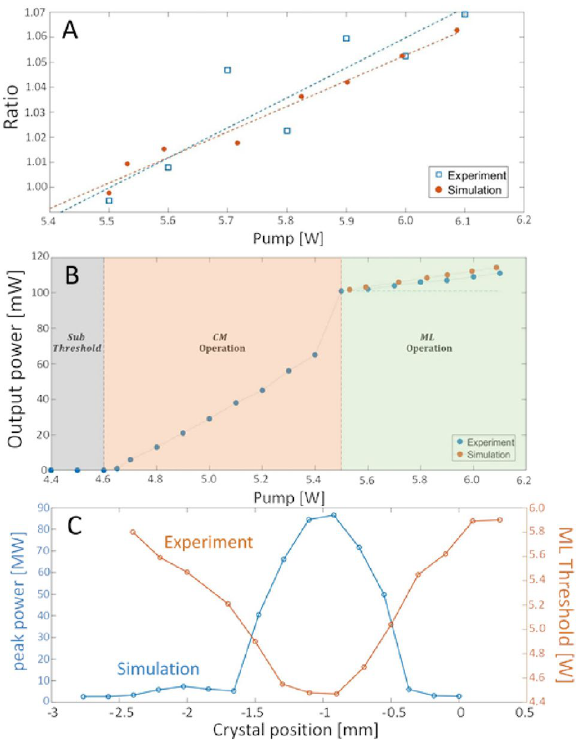
Figure 4. Results: ( A ) Ratio of intra-cavity beam width between the forward and backwards directions. Blue rectangles-measured, as captured on the two cameras (CCD1 and CCD2). Orange circles—numerical simulation. the asymmetry ratio increases with the pump power in accordance with the increase of the total output power and with the deviation from the soliton assumption. ( B ) Output power as function of input pump power, measured experimentally (blue). We observe three regions. (1) Below the lasing threshold, where the output power is low. (2) Above the CW lasing threshold, where the output power varies linearly with the pump. (3) Above the ML lasing threshold, where a linear increase is still observed, but with a lower slope, deviating from the soliton assumption. For comparison, we also show the simulation predicted output power (orange, fitted only for the ML threshold), which predicts nearly the same power slope as the measurement. ( C ) Optimal crystal position for ML efficiency—experiment and numerical simulation. Blue —the numerically calculated ML peak-power, and orange—the experimental ML threshold, as a function of the crystal offset from the focal point of the short arm’s lens towards the long arm of the cavity (see Fig. 1 for definition). Interestingly, the optimal crystal position is offset in the opposite direction from the conventional expectation assuming a soliton